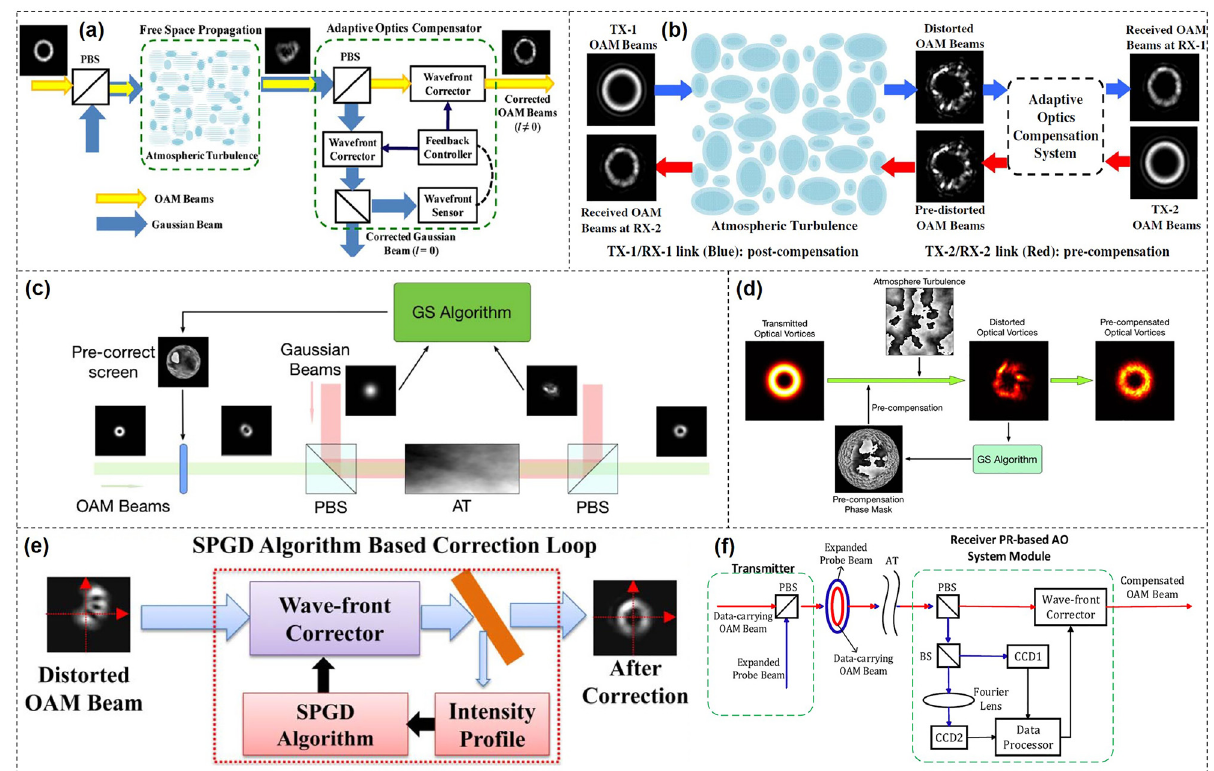
Figure 15: Turbulence compensation based on adaptive optics. (a) Scheme for turbulence compensation of multiple OAM beams using a Gaussian probe beam for wavefront sensing [110]. (b) Concept of simultaneous pre- and post-compensation of multiplexed OAM beams, using a single adaptive optics system [111]. (c) Scheme for the pre- turbulencecompensationbasedonaprobeandtheGSalgorithm[112].(d)ConceptoftheGS-basednon-probepre-compensationof distorted OAM beams [113]. (e) Concept of the GS-based non-probe pre-compensation of distorted OAM beams [114]. (f) Concept of OAM communications with a hybrid input – output algorithm based adaptive optics system [115]. Reprint permission obtained from [110 –